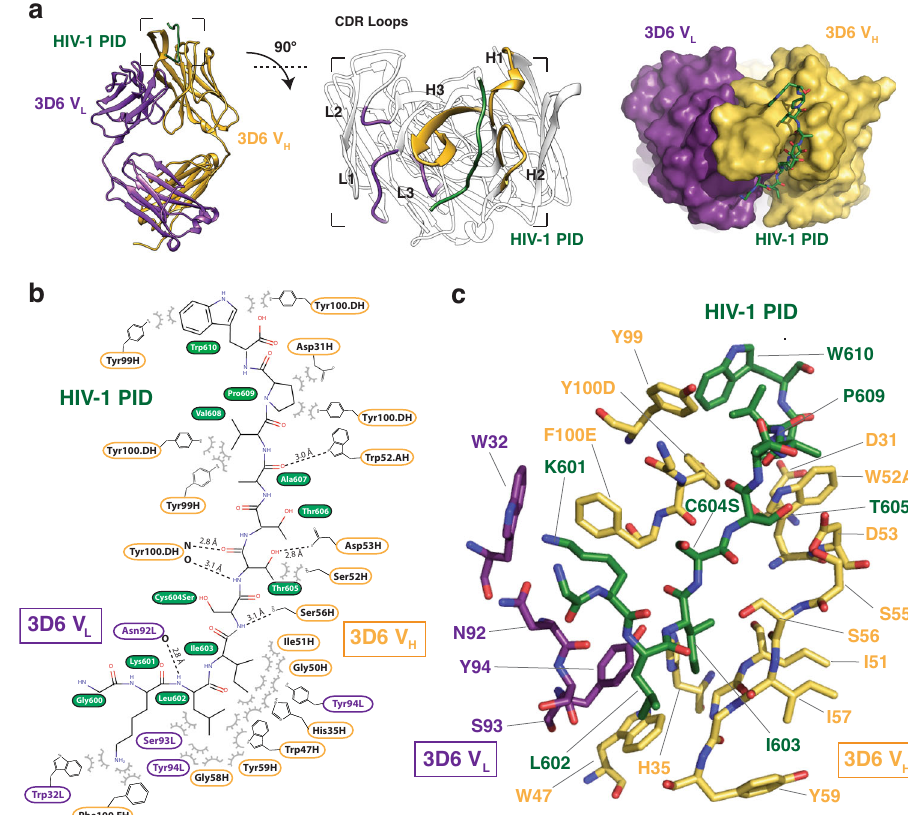
Fig. 2 Overall structure of Fab 3D6 complexed to HIV-1 gp41 PID. a The crystal structure of the Fab 3D6-PID complex shows the PID region in an extended conformation coordinated mainly by the V H subunit. Fab 3D6 CDR-H3 forms a pseudo- β -sheet with the HIV-1 PID. b Interaction map of Fab 3D6 and the PID peptide. Interactions were determined by PISA analysis 80 and manual inspection. Hydrogen bonds are shown by dashed lines. HIV-1 PID residue S598 (wild-type Cys598) was not visualized in this structure. HIV-1 residue S604 (labeled Cys604Ser) is coordinated by a hydrogen bond with Fab 3D6 residue S56H. c Stick representation of the antigen-binding site in which the HIV-1 PID peptide is colored in the dark green, heavy chain in yellow, and light chain in